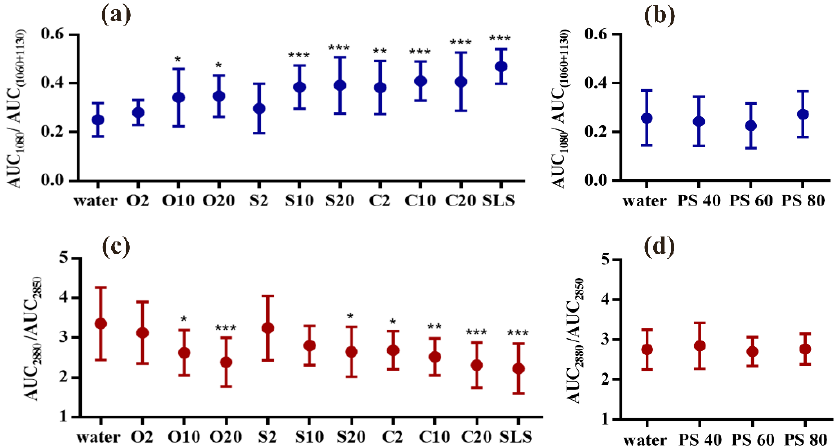
Figure 5. C–C skeleton vibration mode for lipid conformation analysis of ( a ) PEG alkyl ethers